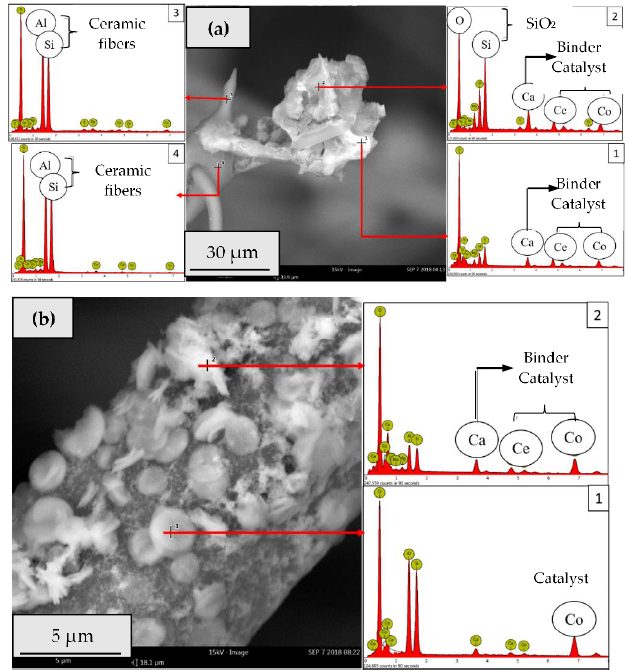
Figure 7. Spot EDX analysis for the identification of catalytic deposits for the sample Co,Ce(5)U-I. ( a ) and ( b ) are different analyzed zones of the sample. ( a , b ) are different analyzed zones of the sample.